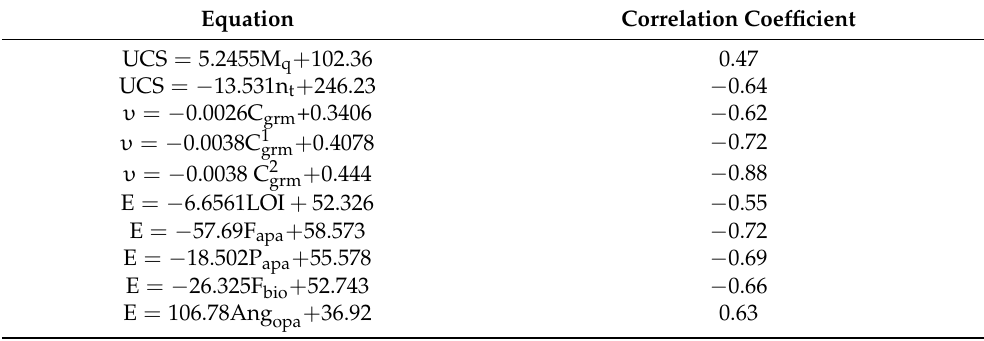
Table 18. Linear regression between mechanical properties and some aspects of rock texture [57] (M g is the mass fraction of quartz (%), n t is total porosity, CGrM is the groundmass content for all types of compositions, C 1 grm is the groundmass content values obtained only from the specimen of andesitic composition, υ is Poisson’s ratio, E is Young’s modulus (GPa), C 2 grm is groundmass content values obtained only from the specimen of rhyodacite composition, A ngopa . is the angularity of opaque minerals, F opa . is Feret’s diameter of opaque minerals (mm), Fbio is Feret’s diameter of biotite (mm), P opa . is the perimeter of opaque minerals, LOI is an indicator of the weathering stage of rock (%), and UCS is uniaxial compressive strength